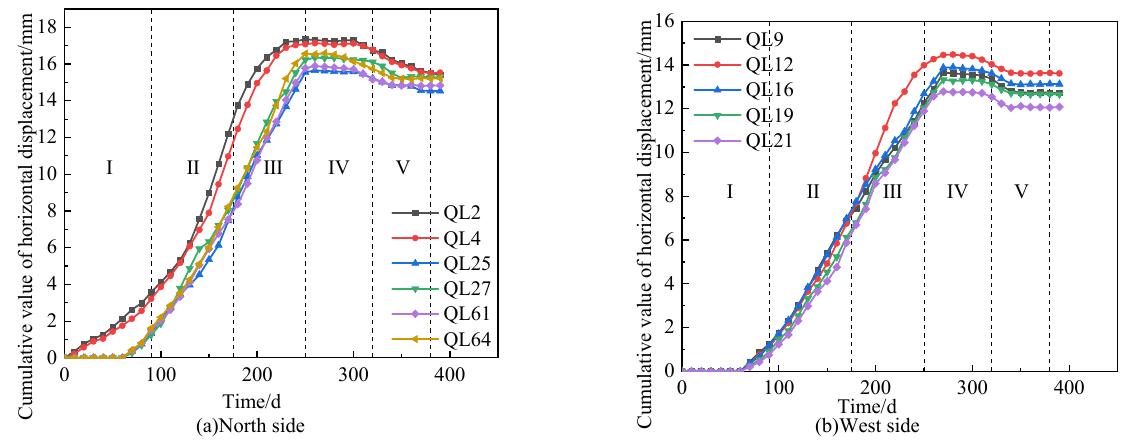
Figure 7. Layout of the monitoring points.